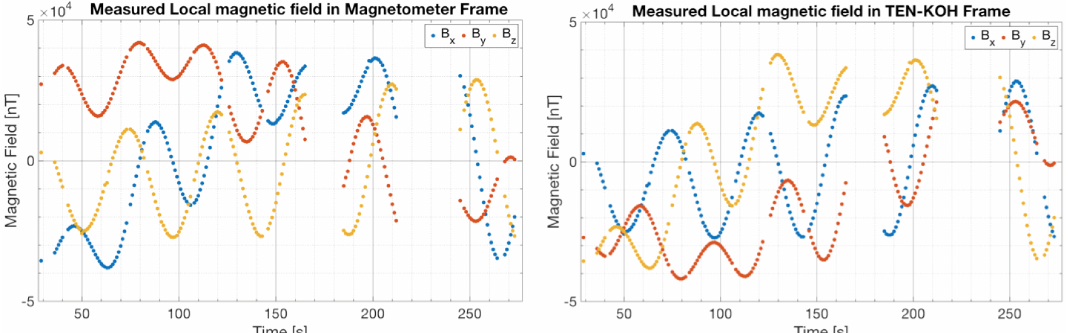
Figure 13. Magnetometer measurements obtained in the instrument frame of reference ( left ) and in the Ten-Koh frame of reference ( right ) for a period of 220 s. The discontinuities come from loss of data packets in the downlinking process during a communication session between the satellite and Kyutech ground station.